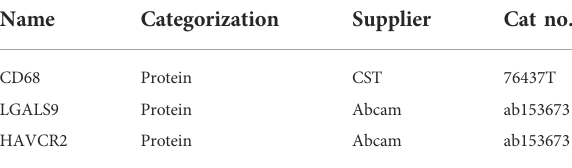
TABLE 1 Resource identi fi cation initiative